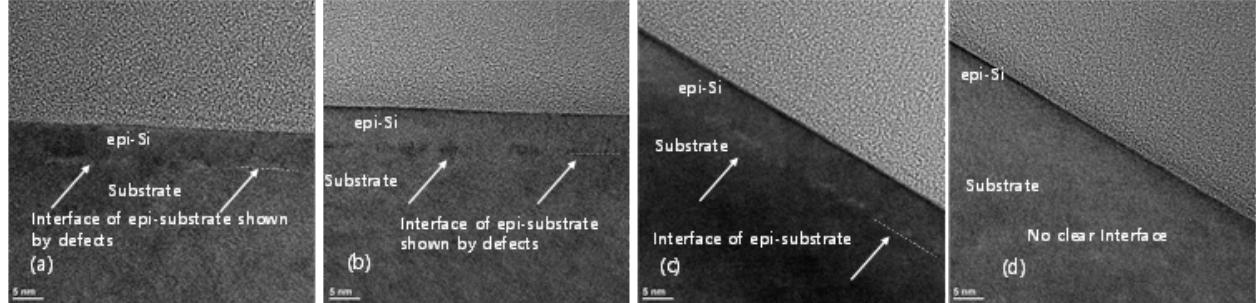
Figure 5. The SIMS O ( a ) and F ( b ) profiles of the Si epitaxial films obtained after wet pre-cleaning and subsequent H 2 bake at various temperatures; ( c ) a bar chart showing the corresponding areal doses of O and F. (700 °C for 10 min, 750, 800, 850 °C for 5 min).